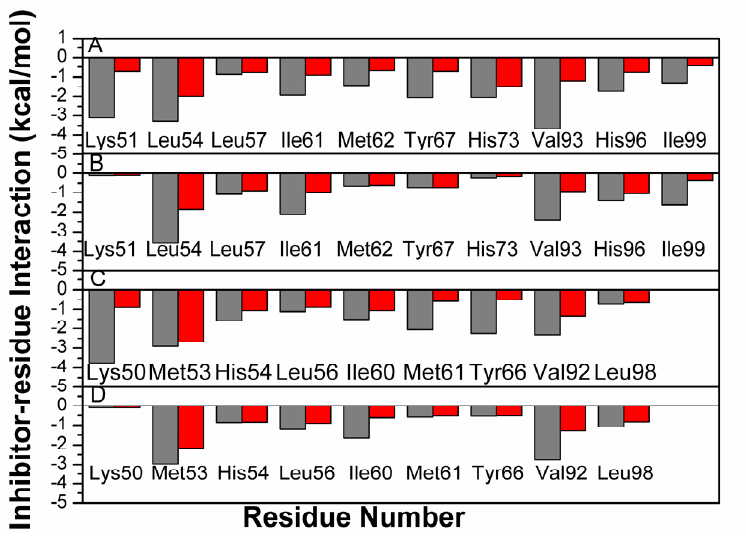
Figure 9. Changes of inhibitor-residue interaction energy caused by alanine scanning. Gray and red are used to represent the interactions of inhibitor with the residues of wild-type protein and mutated protein, respectively. ( A ) pDI6W-MDM2 complex; ( B ) WK23-MDM2 complex; ( C ) pDI6W-MDMX complex; and ( D ) WK23-MDMX